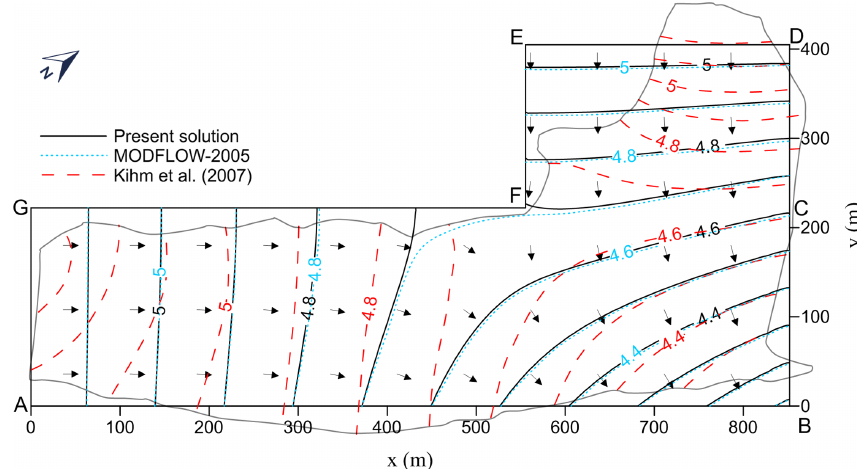
Figure 4. Steady-state hydraulic head contours without pumping in the Yongpoong 2 Agriculture